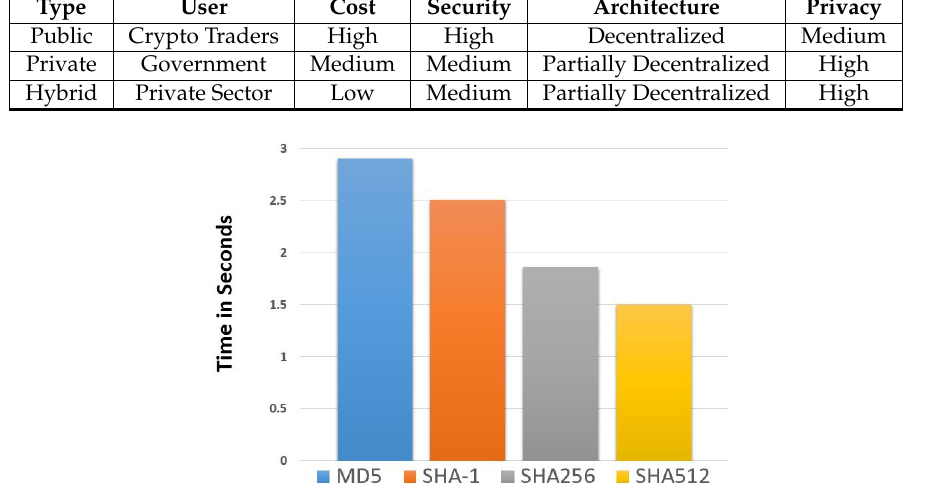
Figure 8. Computational time comparison for different hash functions.